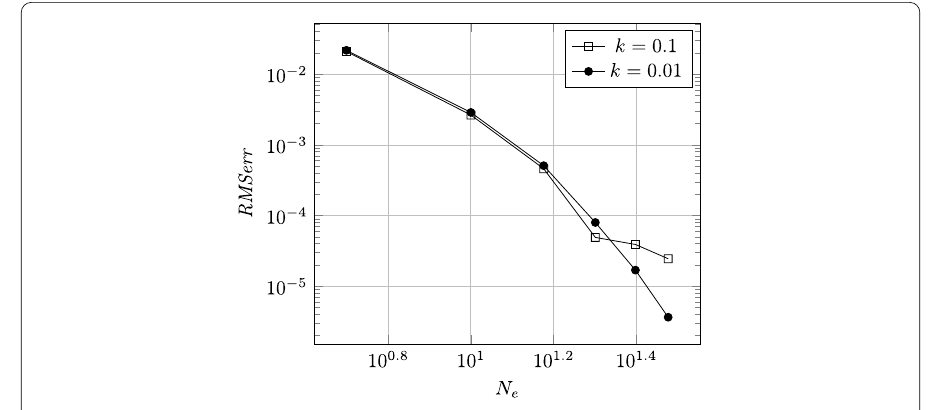
Figure 6 The RMS err as a function of N e : N = 4, k = 0.1,0.01 for Example 5.1